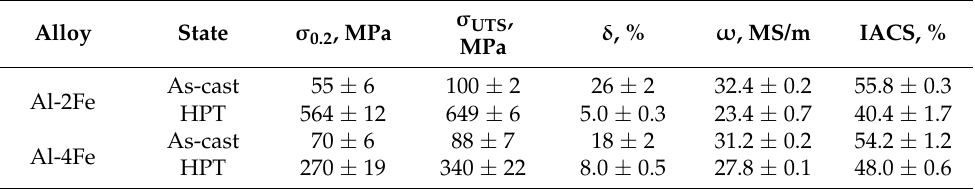
Table 1. Mechanical and electrical properties of Al-Fe alloys in the as-cast state and after HPT. Alloy